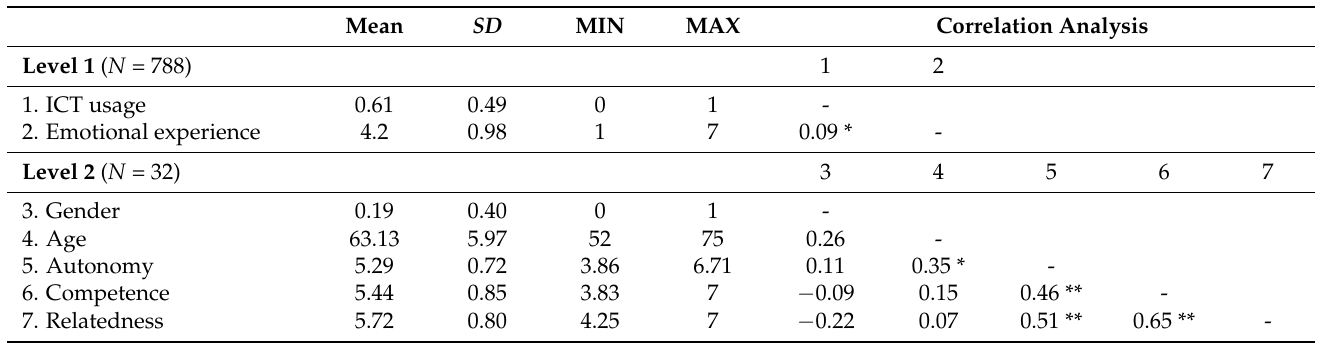
Table 2. Descriptive statistics and correlation